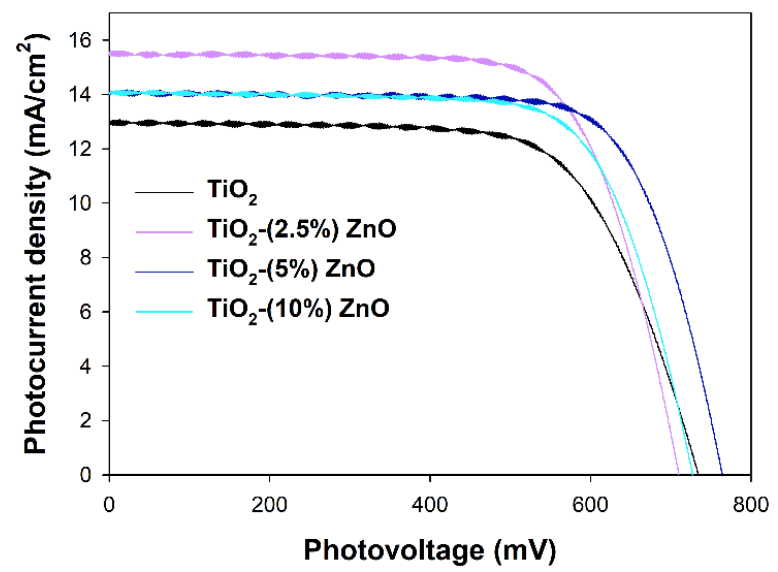
Figure 15. I–V curves registered for investigated TiO 2 -ZnO cells. Table 6. The photovoltaic parameters of DSSCs utilizing TiO 2 -ZnO photoanodes.